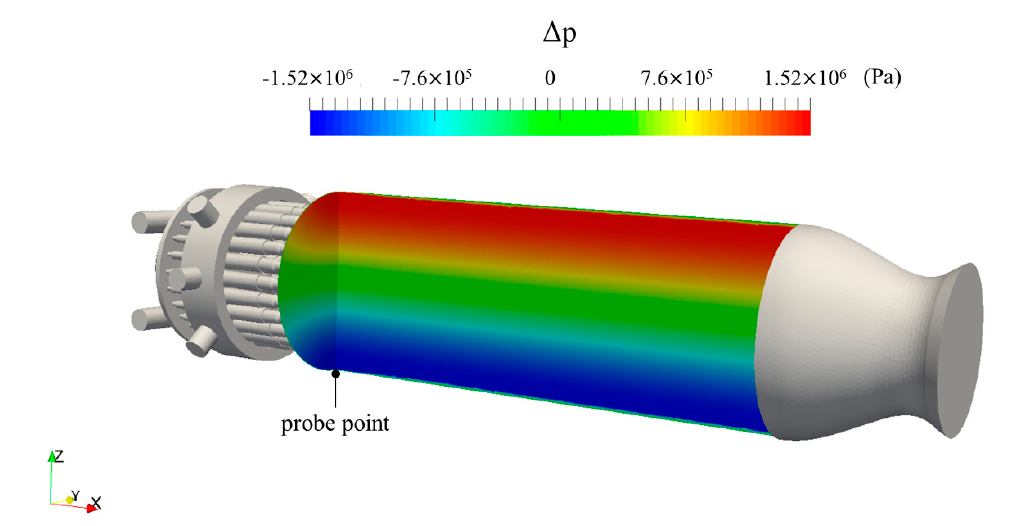
Figure 9. Exact 1st transverse standing wave solution generated on the DLR-BKD combustion chamber with the probe point to measure the pressure history.